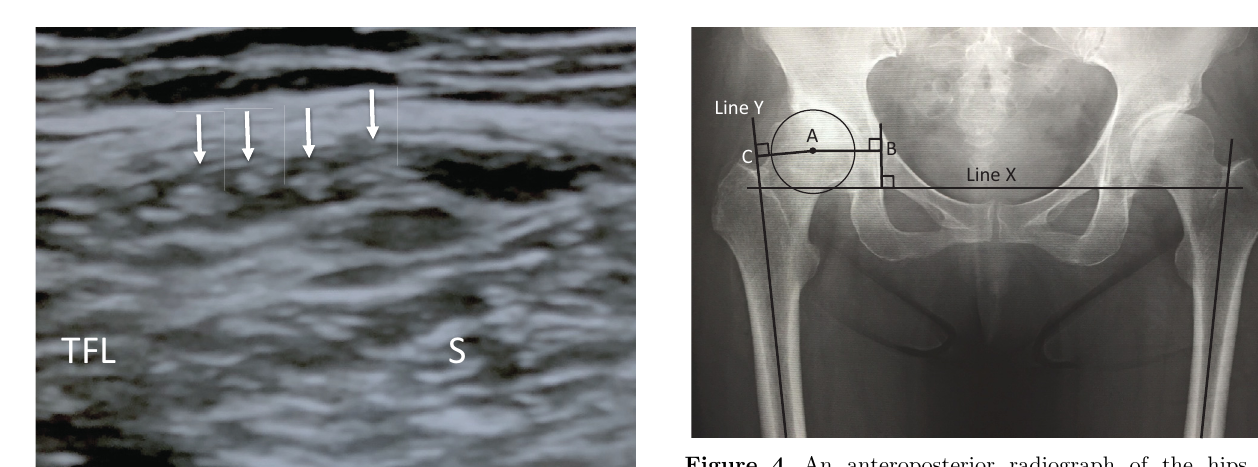
Figure 4. An anteroposterior radiograph of the hips was obtained in a supine position immediately preoperatively. X: trans-teardrop line; Y: central axis of the femur; Z: central axis of the femoral neck; point A: center of the femoral head; AB: acetabular offset; AC: femoral offset. The total offset is the sum of lines AB and AC